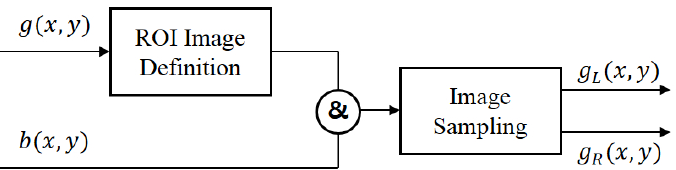
Figure 5. The separating process of phase images from an input